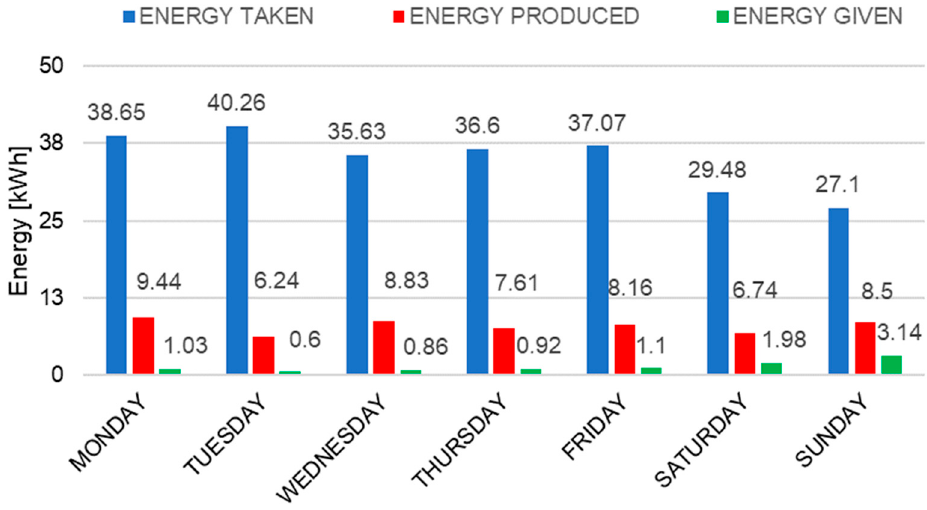
Figure 14. Building’s energy balance. Average daily data from the analysed period: 6 September 2021–21 November 2021.